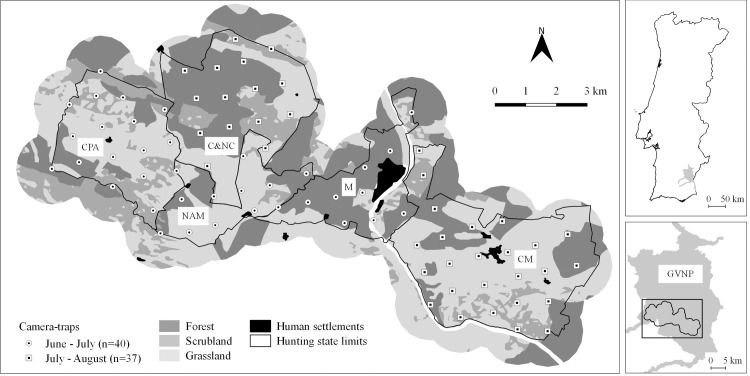
Study area location, hunting estates surveyed (CPA, NAM, C&NC, M and CM), land-cover types and camera-trap stations in the Guadiana Valley Natural Park.